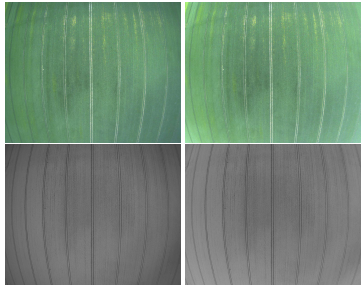
Figure 10: Two raw flight images (VIS+NIR) on the left and the corre- sponding vignetting corrected images on the right. 3.3 Georeferenced Orthophoto Generation